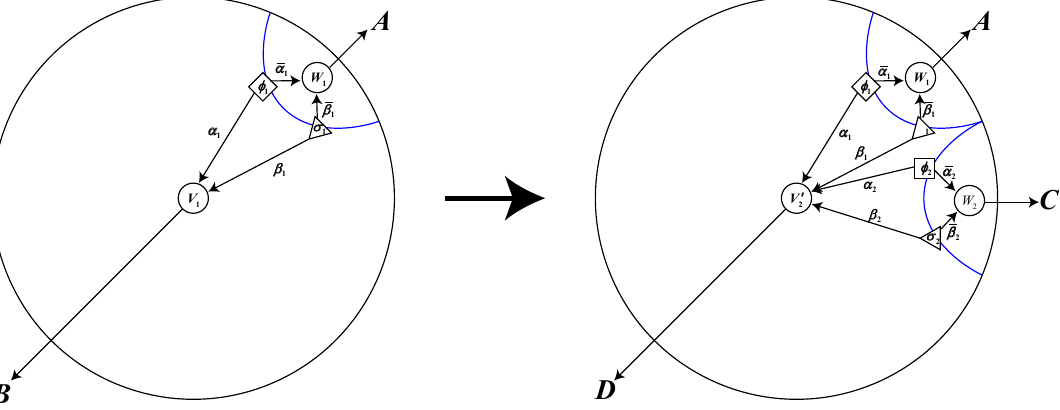
Figure 6 . The resulting tensor network is obtained by replacing the original V 1 tensor with V 1 B = V 0 W 2 | φ i | σ i f 1 α 1 2 2 2